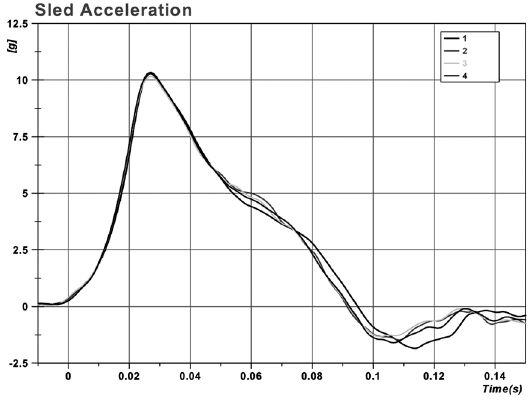
Figure 1. Sled pulse used for rear impact testing. Table 2. Whiplash assessment